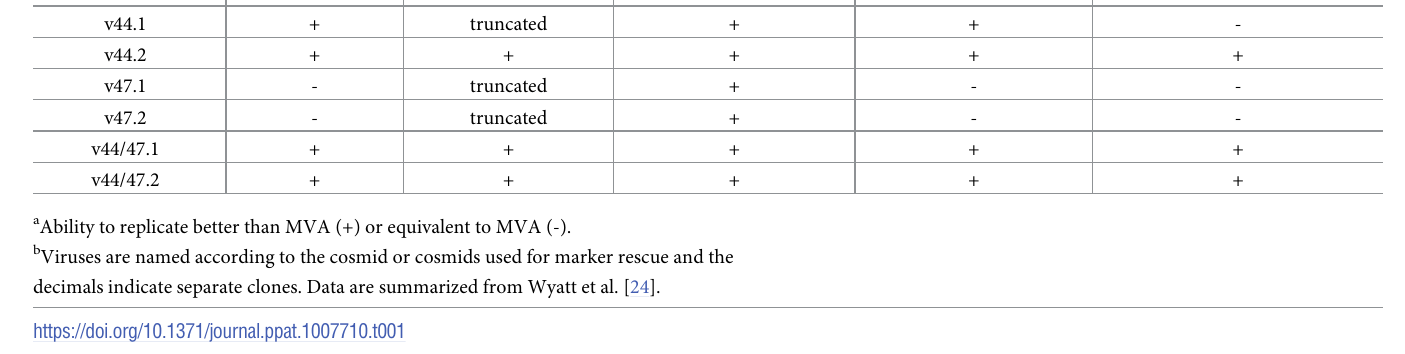
Table 1 summarizes previous PCR data [24] confirming the absence of C12L DNA and trunca- tion of K1L in MVA. Strikingly, C12L was detected by PCR in all HRE MVAs that were able to replicate in human cells, whereas the presence of full-length K1L correlated with replication only in rabbit kidney cells (Table 1). The correlation of C12L and replication in human cells focused our attention on SPI-1 as a missing host-range factor for MVA. Unlike most ortho- poxvirus host-range mutants, which exhibit blocks in gene expression, the earliest recognized defect in MVA replication occurs during morphogenesis [15, 18, 32]. Interestingly, the second exception to the general rule for the predominance of impaired gene expression is the morpho- genesis defect of SPI-1 deletion mutants of rabbitpox virus and the WR strain of VACV in